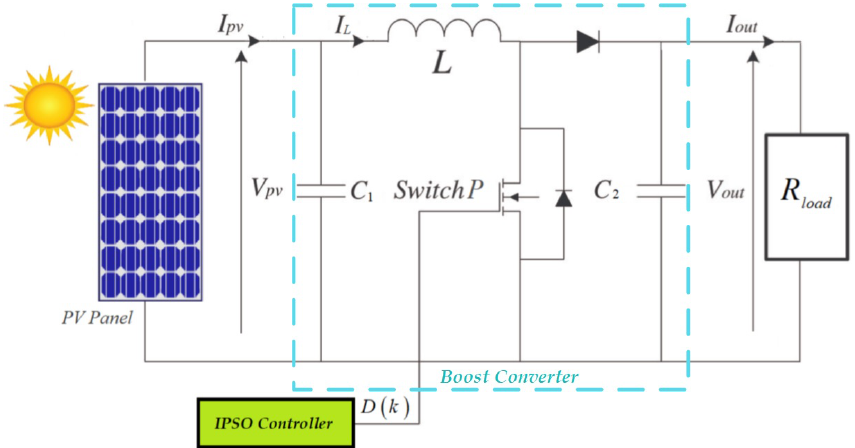
Figure 1. Electric scheme of the adopted photovoltaic (PV)